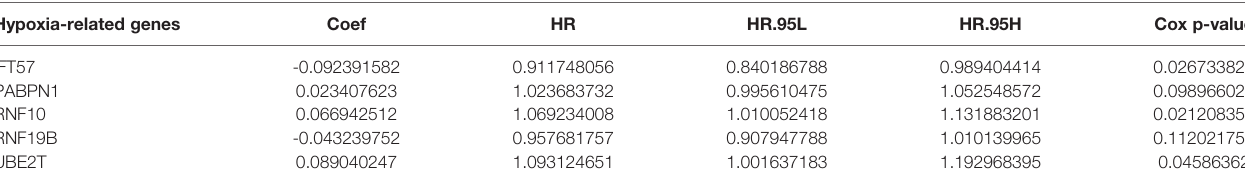
TABLE 1 | Identi fi cation of prognostic hypoxia-related genes in the multivariate cox regression. Hypoxia-related genes Coef HR HR.95L HR.95H